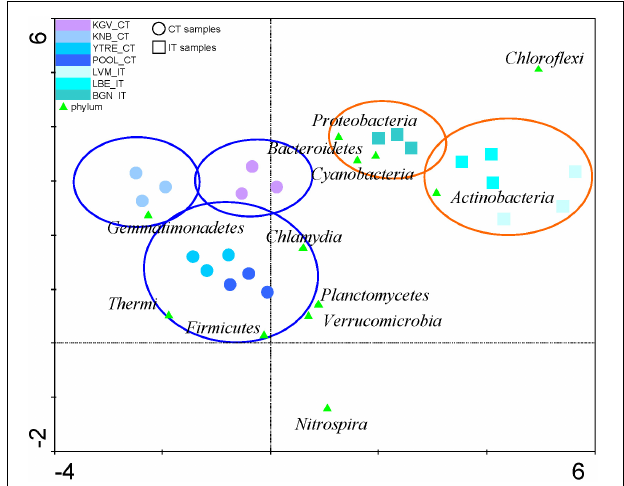
FIGURE 4 | Detrended Correspondence Analysis. The relative abundances of the microbial phyla from tidewater samples were compared to find their gradient. The diagram displays triangles that represent phyla. Sampling sites are represented by different shapes ( ◦ : CT samples and (cid:3) : IT samples). Venn diagrams cluster and discriminate sampling points in different groups (glacier orange diagrams and tidewater blue diagrams). The axes are scaled in standard deviation units. CT, samples from the tidewater area closest to a coastal glacier; IT, samples from the tidewater area closest to an inland